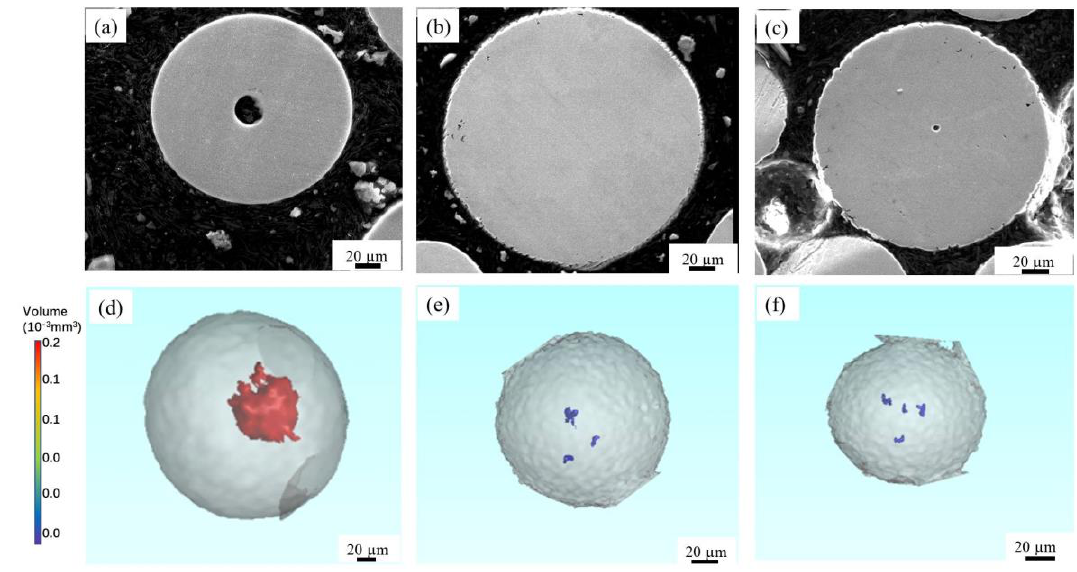
Figure 3. Cross-sectional morphology of the alloy powders by scanning electron microscopy (SEM) at 8000 RPM ( a ) Ti-6Al-4V, ( b ) Co-Cr-Mo, ( c ) 316-Steel [25]; 3D reconstructed computed tomography (CT) images of ( d ) Ti-6Al-4V, ( e ) Co-Cr-Mo, ( f ) 316L.